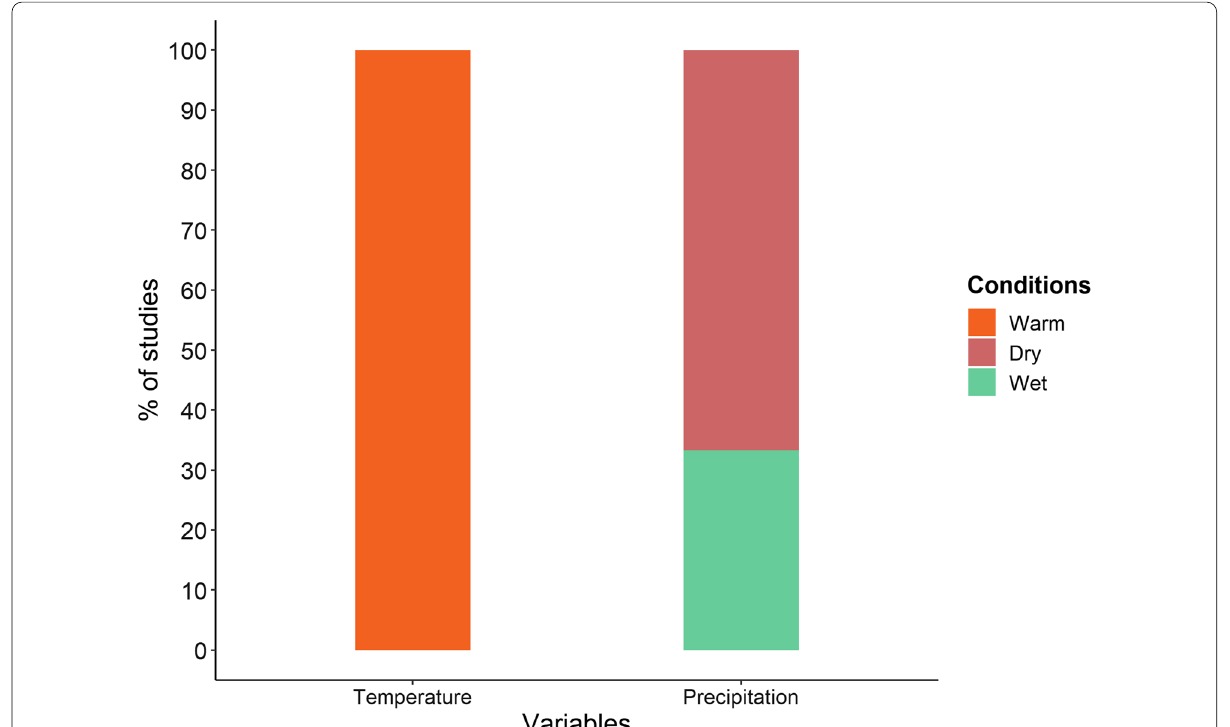
Fig. 8 Relationship of temperature and precipitation during the MCA. The number of studies used for the warm/cold or wet/dry conditions can be found in Table